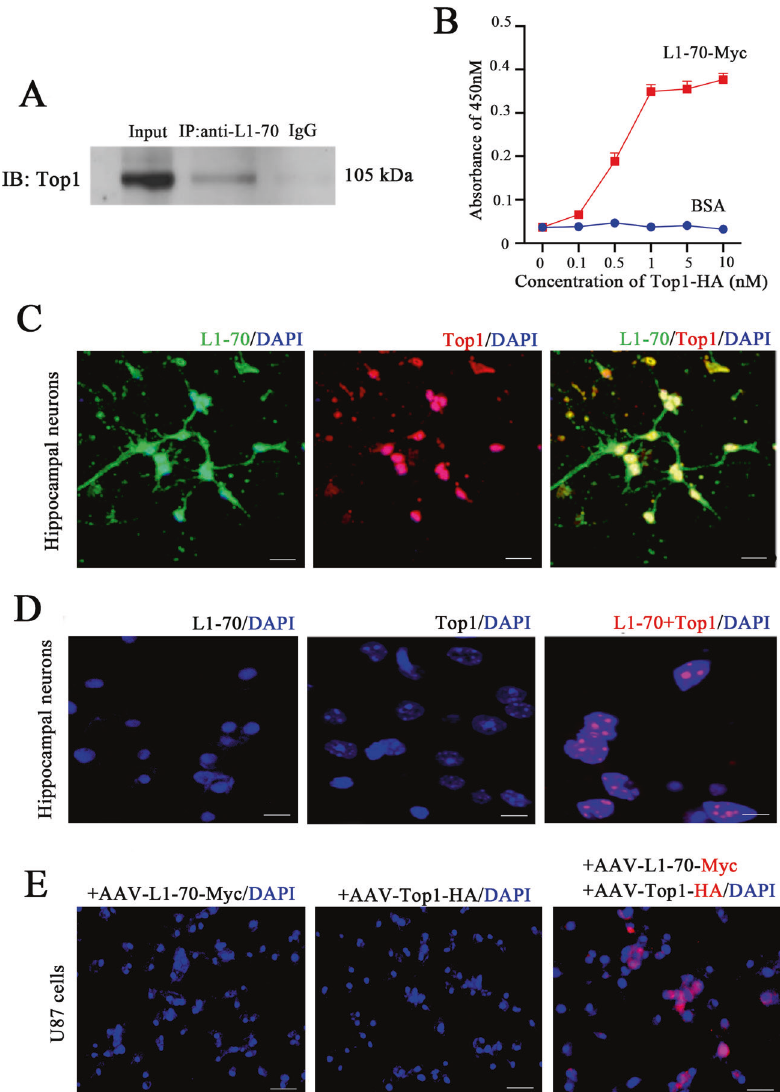
Fig. 3 L1-70 is associated with Top1. A Co-immunoprecipitation of the hippocampus tissue homogenates from 5- to 7-day-old wild-type mice with an antibody against L1 cytoplasmic domain being used for the co-immunoprecipitation and antibody against Top1 being used for western blotting. B ELISA for measuring the interaction between L1-70 and Top1 which were prepared from genetically engineered bacteria expressing recombinant L1-70-Myc and Top1-HA. Antibodies against Myc and HA tags were used for the identi fi cation of L1-70 protein and Top1 protein. The absorbance of L1-70-myc increased with the higher concentration of Top1-HA and showed saturation at 1 nM. C Co-expression of L1-70 and Top1 in primary cultured cells from the hippocampus of wild-type newborn mice. Immuno fl uorescence staining for L1-70 and Top1. L1-70 (green) colocalized with Top1 (red) in the nucleus. D Proximity ligation assay (Duolink) of the interaction between endogenous L1-70 protein and Top1 protein in primary hippocampal neurons from wild-type newborn mice. L1-70/Top1 complexes are indicated by the red dots. E Proximity ligation assay (Duolink) of the interaction between recombinant L1-70-Myc protein and Top1-HA protein transduced in U87 cells (which lack expression of L1) with recombinant adeno-associated virus expressing L1-70-Myc or/and Top1-HA. Antibodies against Myc and HA tags were used in the Duolink analysis. Three groups were transduced with recombinant viruses, AAV-Top1-HA, AAV-L1-70-Myc, or both. Positive signals could be found only in U87 cells transduced with both adeno-associated viruses. Scale bar: 20